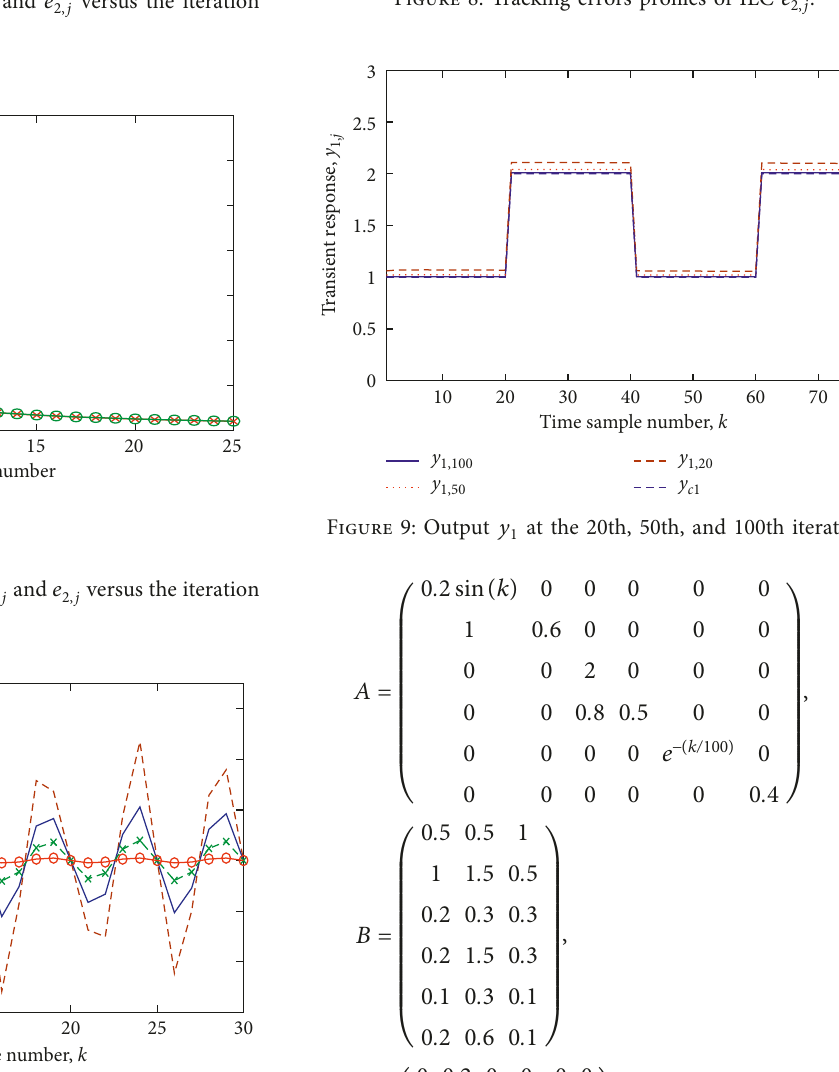
Figure 8: Tracking errors profiles of ILC e